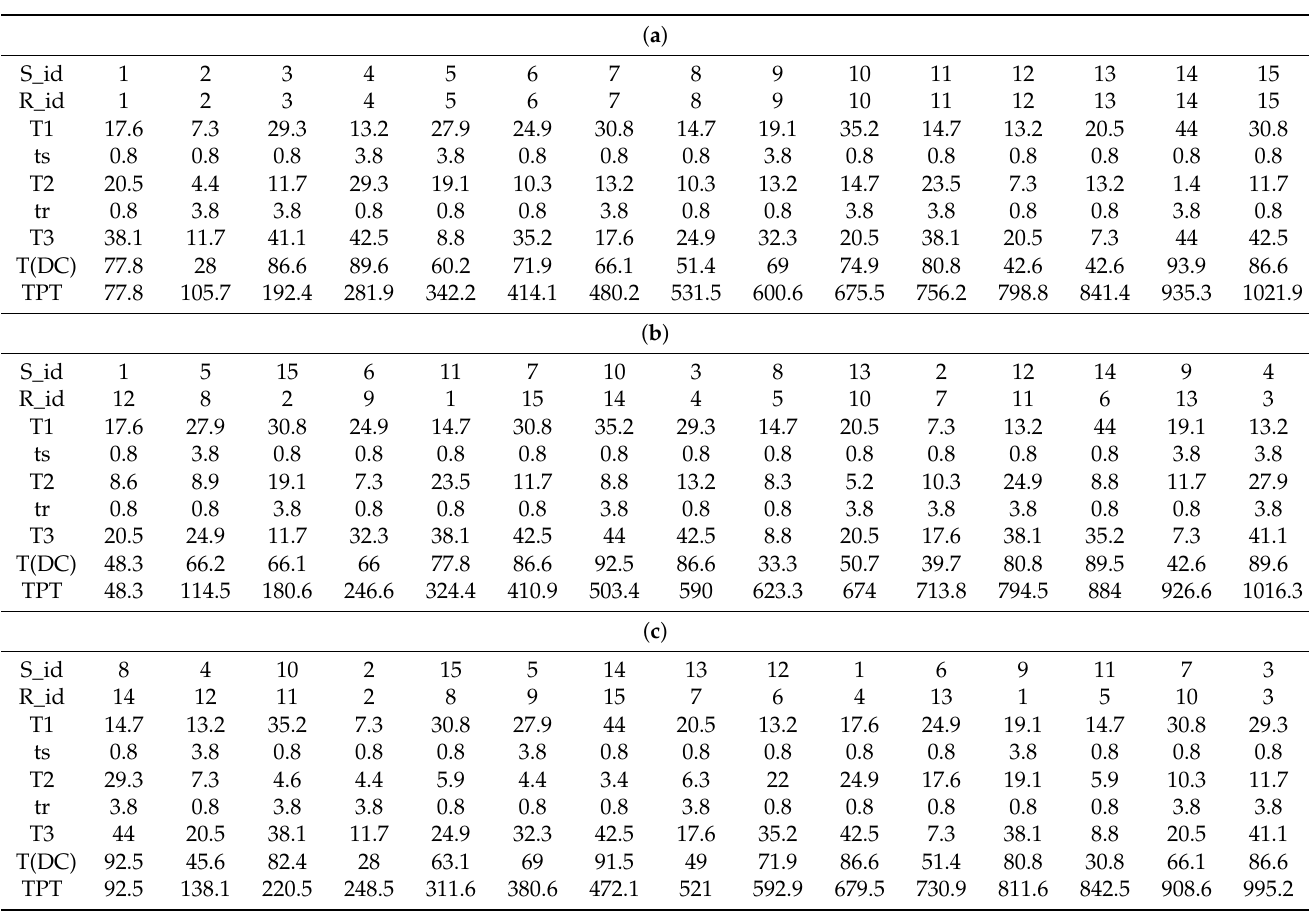
Different approaches are then used to find the best solution. Table 3a–f show the experimental results obtained by (a) FCFS, (b) RANDOM, (c) the WOA, (d) the GA, (e) PSO, and (f) the IWOA+DP. Table 3. ( a ). The best solution found by FCFS (problem size: N × N = 15 × 15). ( b ). The best solution found by RANDOM (problem size: N × N = 15 × 15). ( c ). The best solution found by WOA (problem size: N × N = 15 × 15). ( d ). The best solution found by GA (problem size: N × N = 15 × 15). ( e ). The best solution found by PSO (problem size: N × N = 15 × 15). ( f ). The best solution found by the IWOA+DP (problem size: N × N = 15 ×